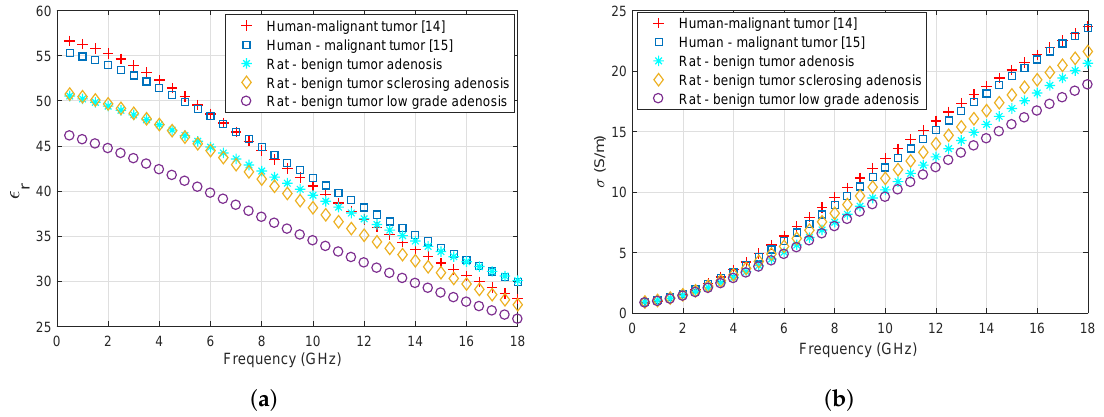
Figure 7. Dielectric property comparisons of ex vivo malignant human breast tumor tissues and in vivo rat benign breast tumor tissues: ( a ) Relative permittivity values; ( b ) Conductivity values. Relative permittivity discrepancy for the whole frequency band between the malignant human tumor values reported in [14] and rat low-grade adenosis, adenosis and sclerosing adenosis are 24.6%, 6.0%, 5.5%, respectively. Relative permittivity discrepancy for the whole frequency band between the malignant human tumor values reported in [15] and rat low-grade adenosis, adenosis and sclerosing adenosis are 32.1%, 6.6%, 10.0%, respectively. Conductivity discrepancy for the whole frequency band between the malignant human tumor values reported in [14] and rat low-grade adenosis, adenosis and sclerosing adenosis are 47.9%, 22.6%, 19.6%, respectively. Conductivity discrepancy for the whole frequency band between the malignant human tumor values reported in [15] and rat low-grade adenosis, adenosis and sclerosing adenosis are 41.2%, 17.0%, 14.1%, respectively. The dielectric property discrepancy between human fibroglandular tissues and malignant tumors is reported to be 10%. Here, the reported discrepancy between the rat benign tumors and malignant human tissues is lower than 10% for sclerosing adenosis and adenosis tissues and higher than 14% for sclerosing adenosis and adenosis tissues. The dielectric property discrepancy is above 24% for low-grade adenosis. Microwave hyperthermia treatment aims to heat up the malignant tumors. The healthy tissues are used for modelling purposes during design of microwave treatment and diagnostic